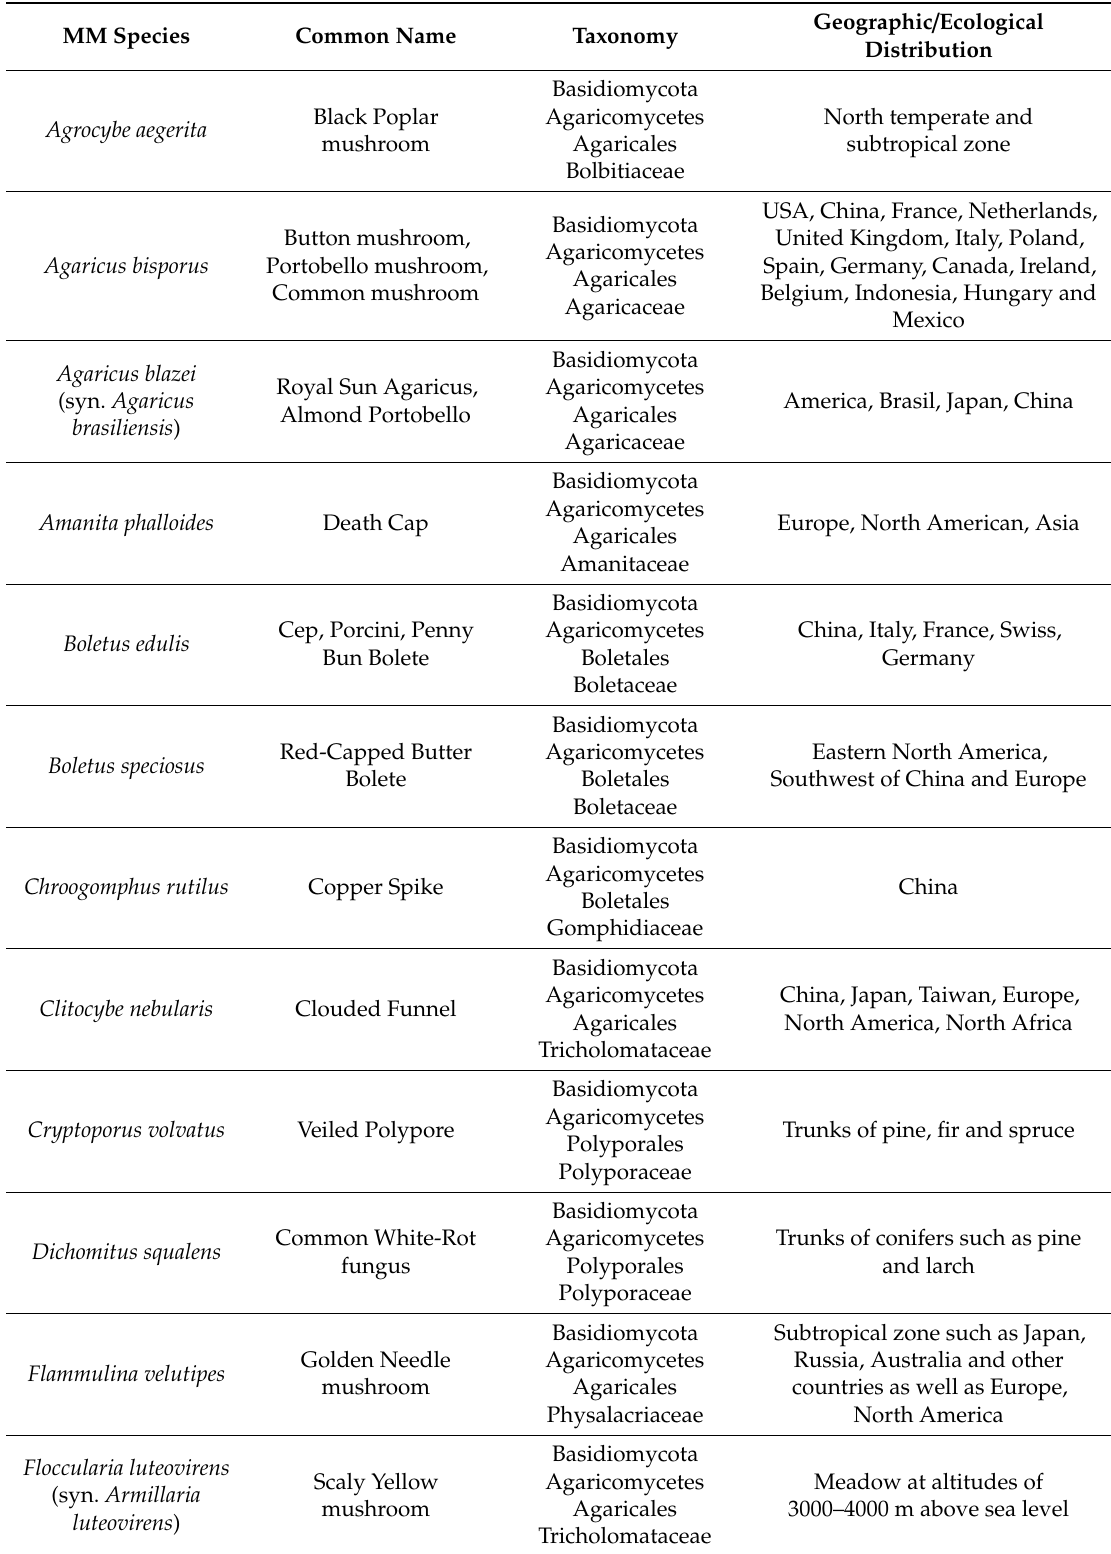
Table 1. Major medicinal mushrooms and their main